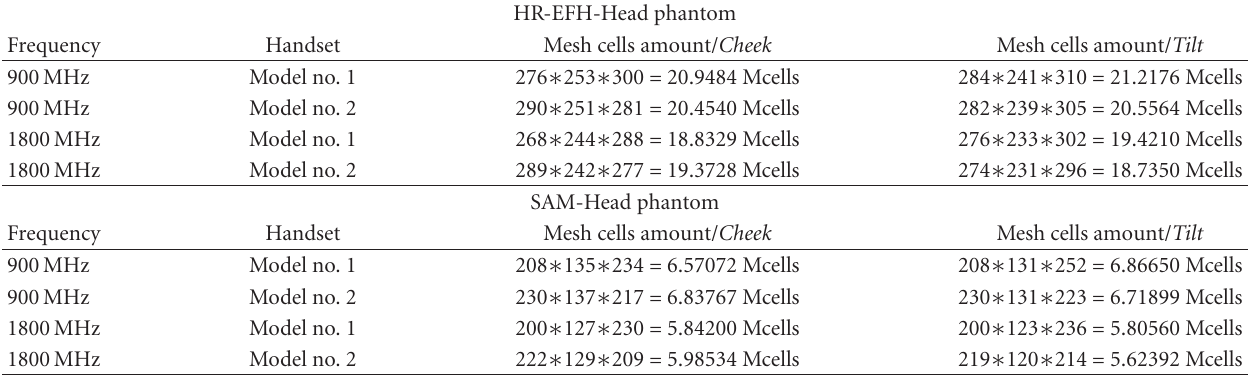
Table 2: The generated FDTD-grid properties of both handset models in hand close to head, SAM and